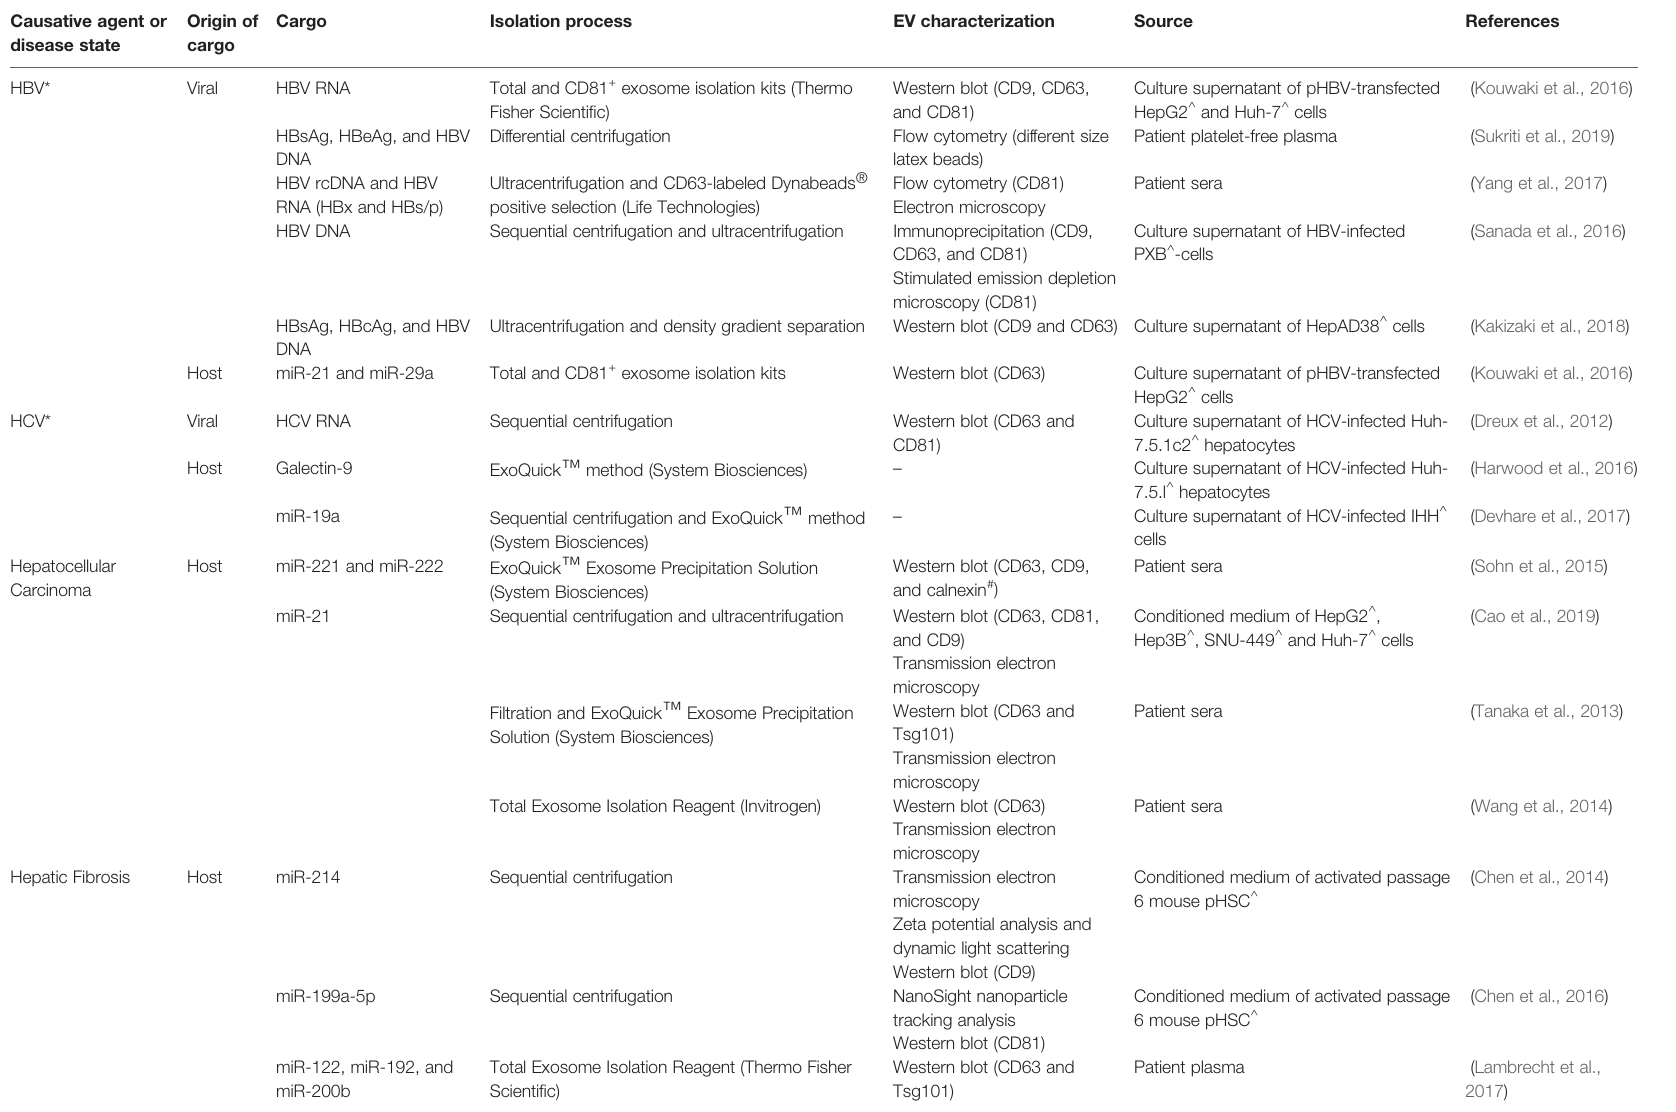
TABLE 2 | Involvement of extracellular vesicles (EVs) in chronic liver